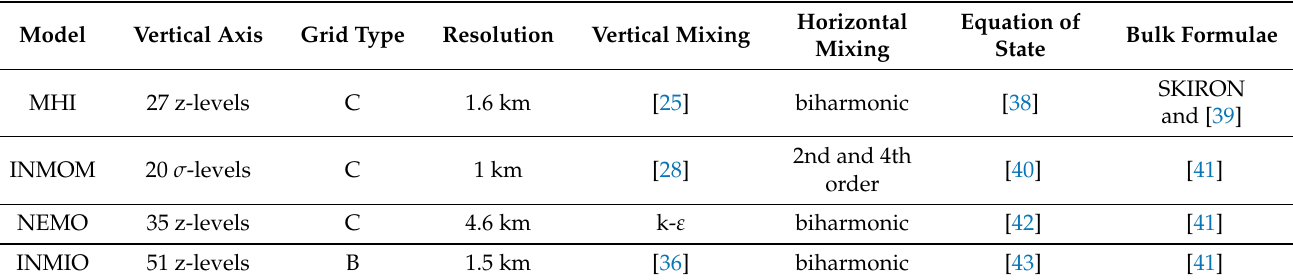
Table 1. Parameters of the numerical